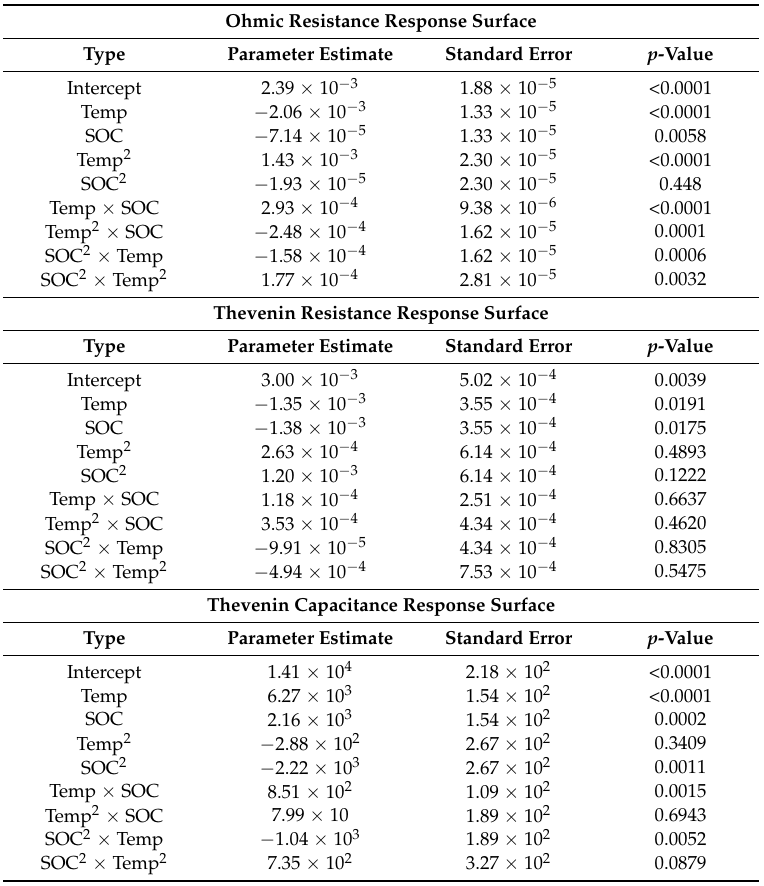
Table 4. Empirical model parameters for the change in R 0 , R 1 and C as a function of temperature and